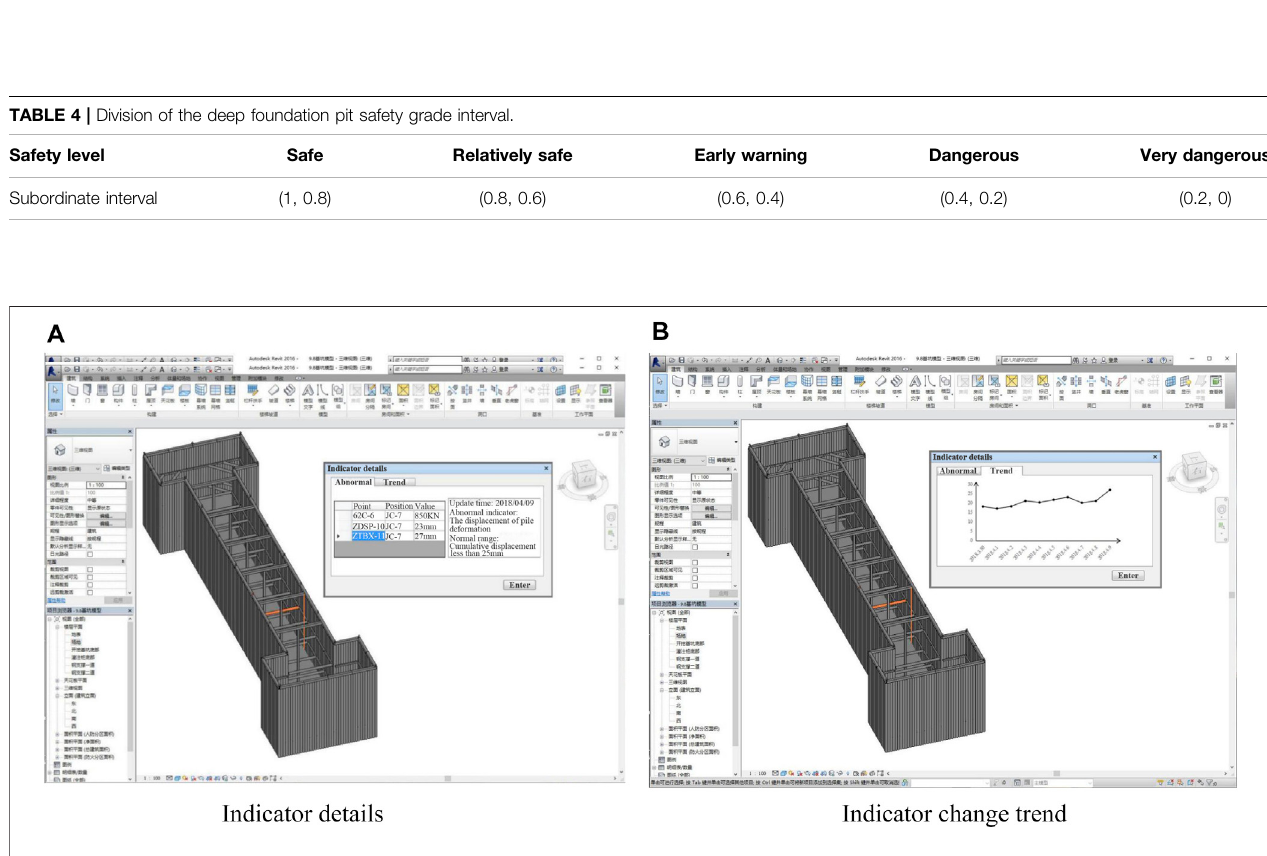
FIGURE 4 | Details of the abnormal units and trend diagram of the abnormal units. (A) Indicator details, (B) Indicator change trend.